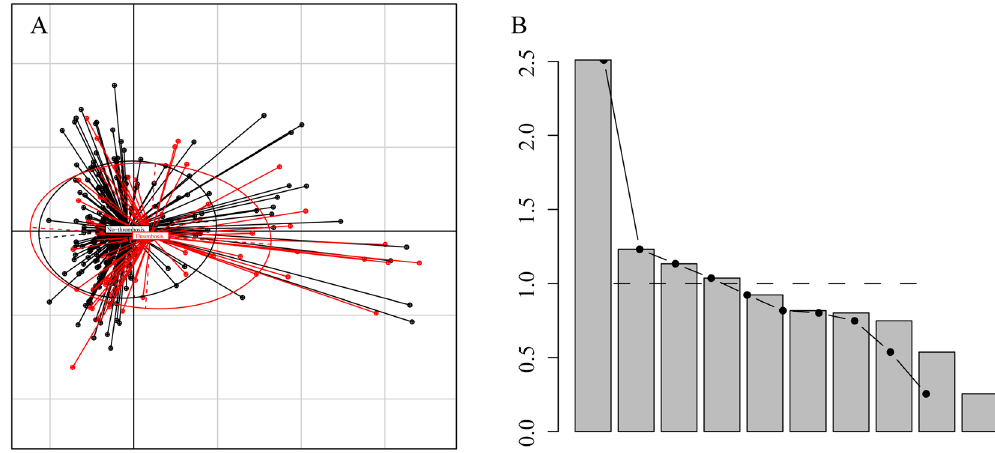
Figure 3. ( A ) The cluster of potential ten risk factors that associated with thrombosis. The plot shown the factorial maps with representation of observation scores. ( B ) The scree plot indicated principal components.